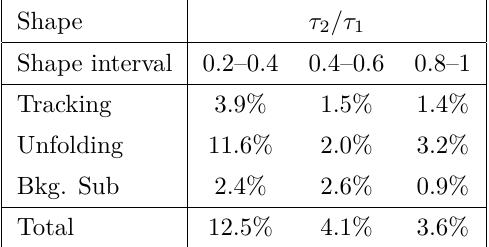
Table 2 . Relative systematic uncertainties on the τ 2 /τ 1 shape, measured using k T reclustering, √ are shown in 0 – 10% most central Pb-Pb collisions at s NN = 2 . 76 TeV for three selected intervals of the observables in the jet p ch range 40 – 60 GeV/ c . All sources of systematic uncertainty are T , jet considered to be